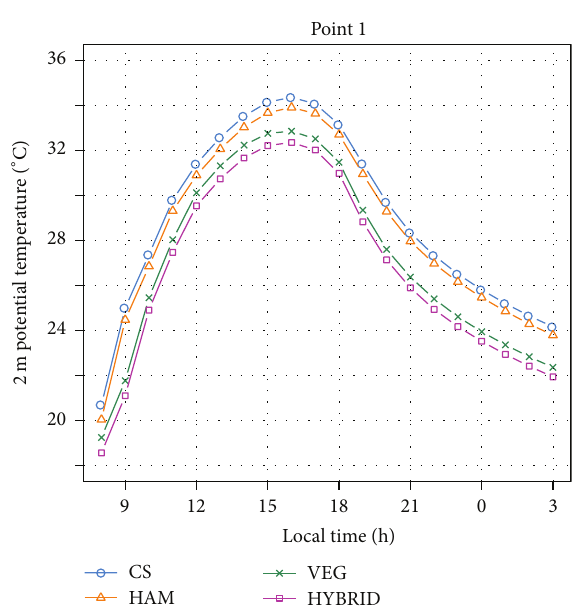
Figure 15: 2m potential temperature time series at Point